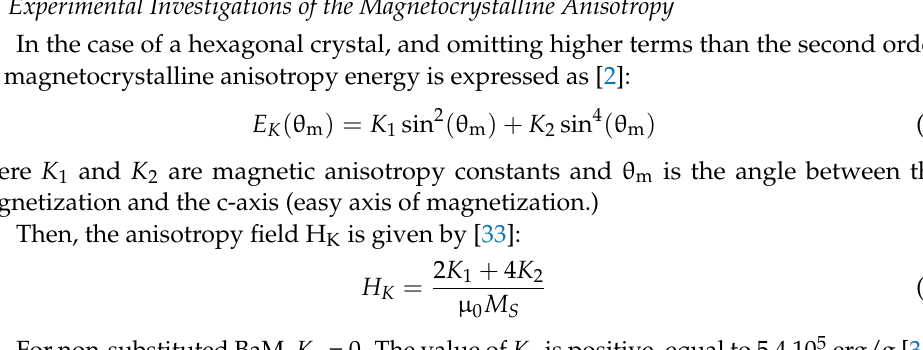
Figure 8. Probability density of crystallite orientations, from March–Dollase model.